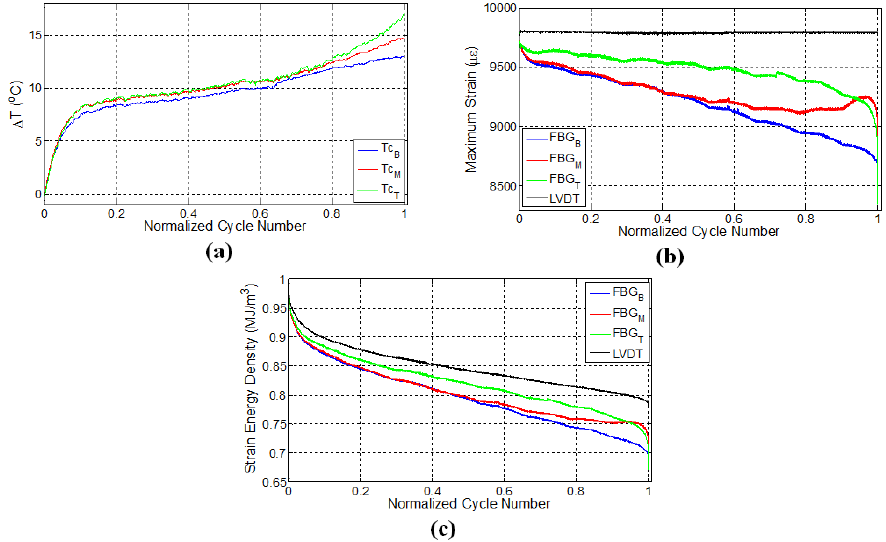
Figure 3. Evolution of ( a ) temperature; ( b ) strain and ( c ) strain energy density for specimen L1 where temperature is monitored by thermocouples, while the strain data are obtained using both FBG and LVDT sensors. The letters B, M and T in subscripts refer to the sensor locations: bottom, middle and top,